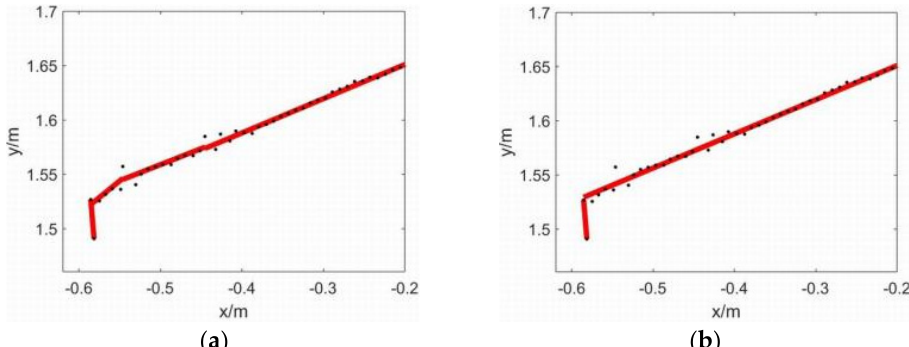
Figure 10. Area 1 line fitting results: ( a ) IEPF algorithm; ( b ) proposed algorithm.